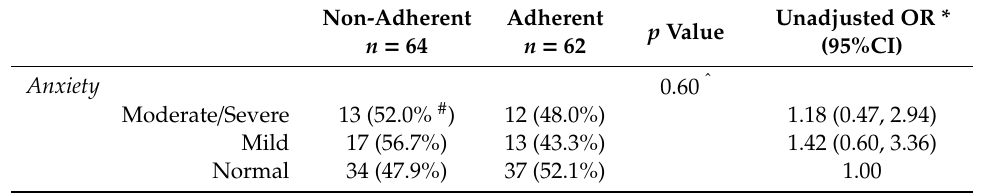
Table 4. Percentage of group non-adherent and adherent and risk of anxiety and depression and personality